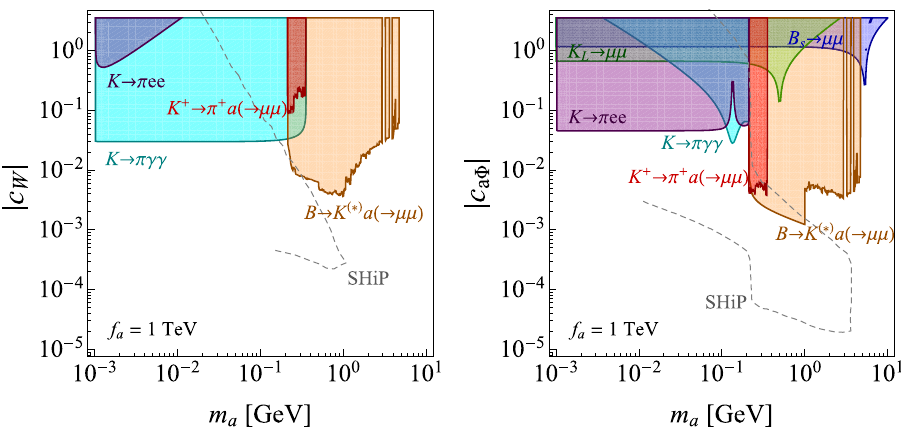
Fig. 5 VisibleALP:constraintsontheabsolutevalueof c W (leftpanel) and c a (cid:7) (rightpanel)whenthesecouplingsareconsideredseparately,as a function of the ALP mass and for f a = 1 TeV. The exclusion contours follow from the experimental limits on K + → π + a ( → μμ) (red) [76], B → K ( ∗ ) a ( → μμ) (orange) [73,74], B ( K L → μμ) (green) Fig. 6 Visible ALP: Allowed parameter space when the couplings { c aW , c a (cid:7) } are simultaneously present, for f a = 1 TeV and m a = 0 . 1 GeV (upper plots) or m a = 0 . 3 GeV (lower plots). The different flat directions observed in the figures correspond to the destructive interferences of both couplings in ALP production and/or the various ALP channel decays, which depend on the sign of c W / c a (cid:7) . See text for